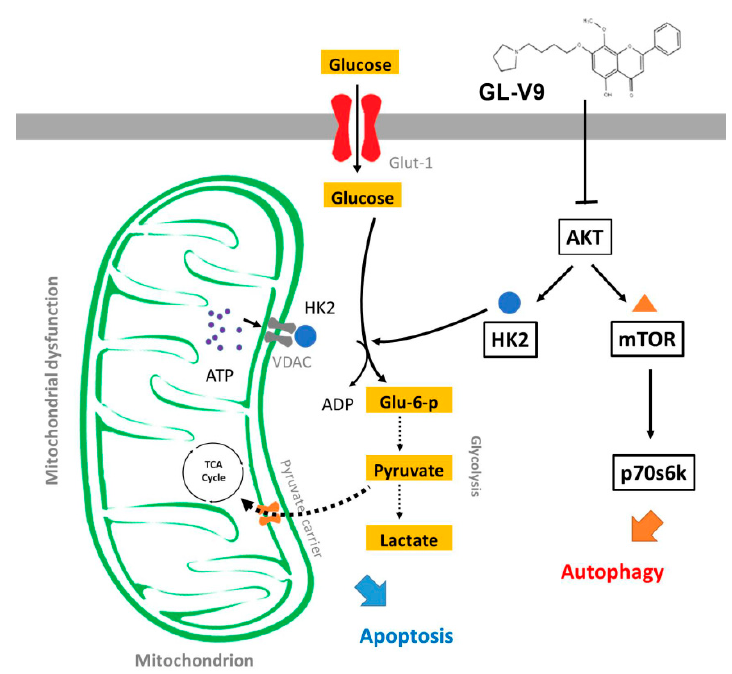
Figure 8. Schematic representation of GL-V9 inducing apoptosis and autophagy via inhibition of AKT-mediated mitochondrial location of HK2 and AKT/mTOR pathway in cSCC.